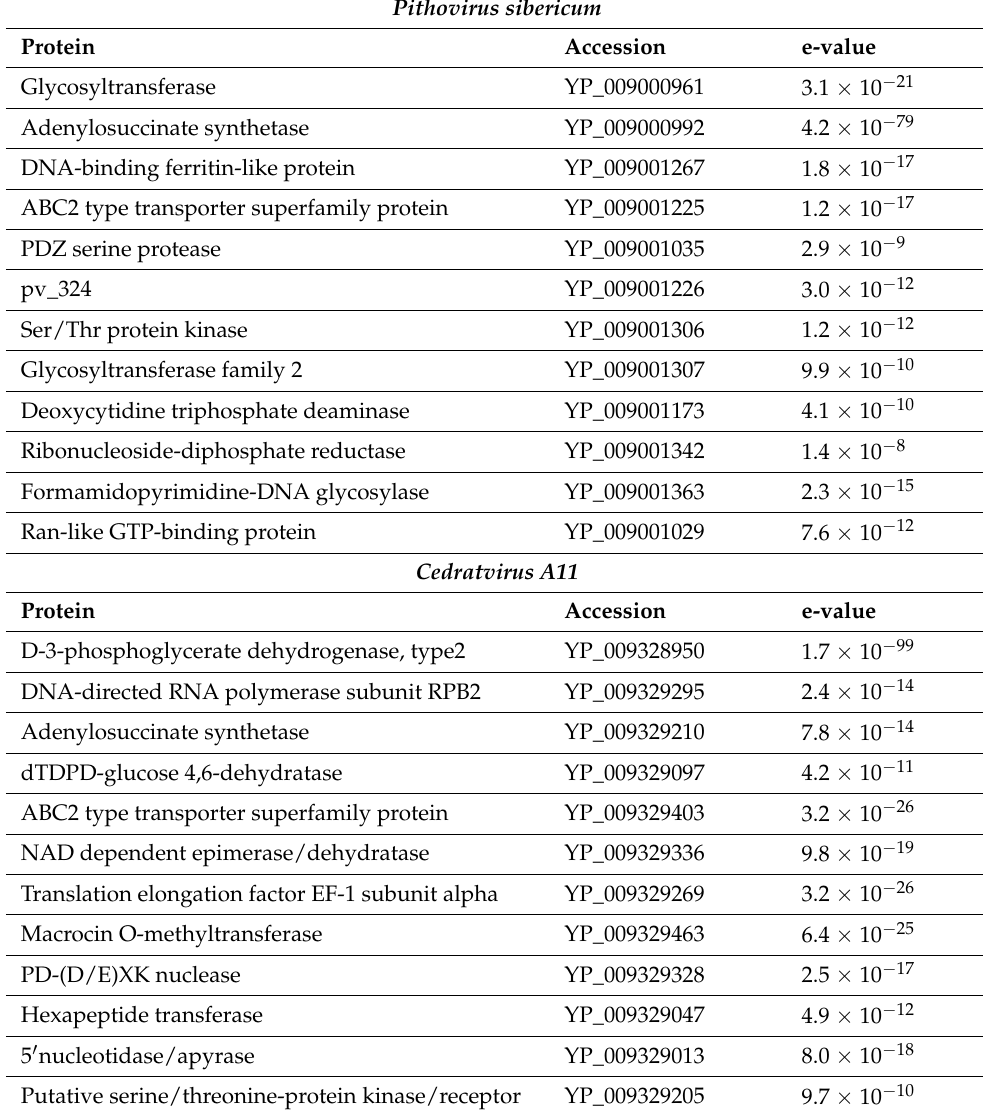
Table 1. Identified proteins similar to Pithovirus sibericum and Cedratvirus A11 (Nucleocytoviricota) according to the RefSeq